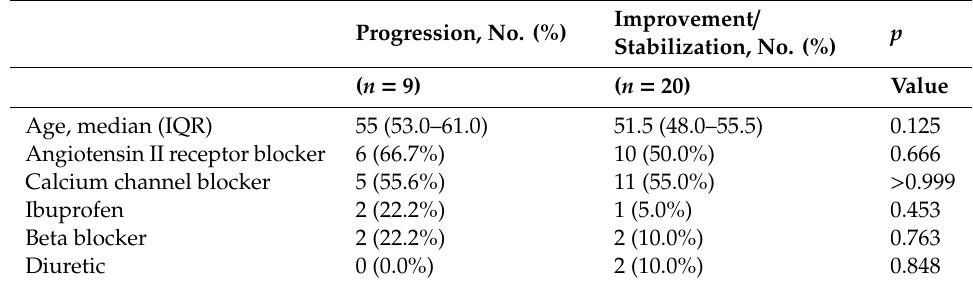
Table A2. Subgroup analysis of the e ff ect of prior use of drugs in COVID-19 patients with hypertension. Progression, No. (%)